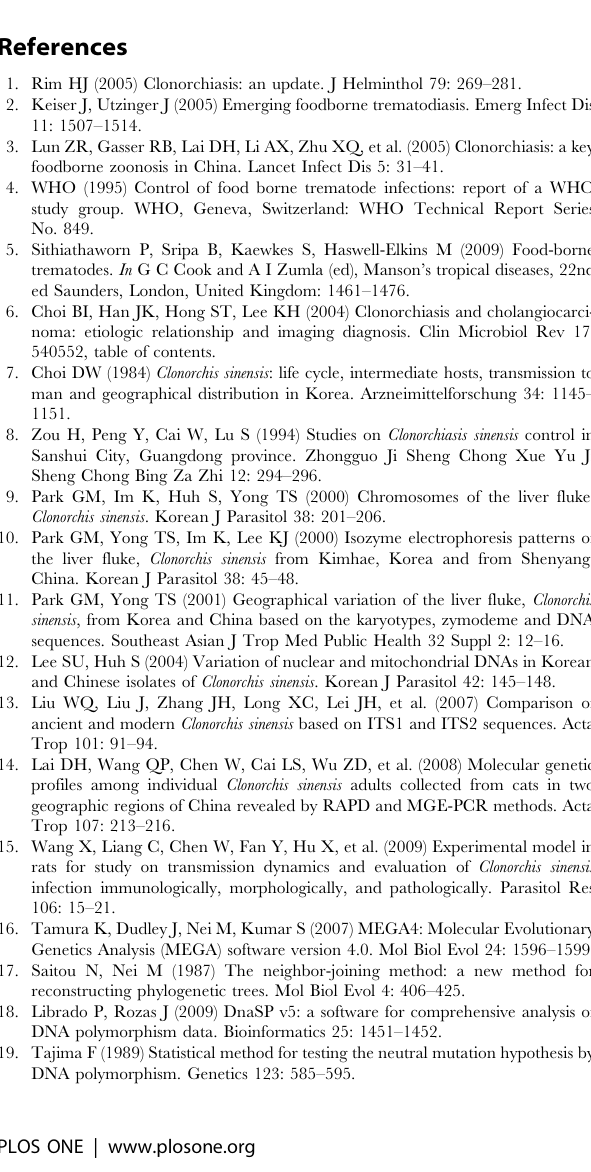
Figure S2 The haplotype networks constructed for cox1, cox3, nad4 , and nad5 . (TIF) Table S1 The MST profiles of the 256 Clonorchis sinensis isolates from 17 provinces of China typed in this study. (DOC) Table S2 Primers used in this